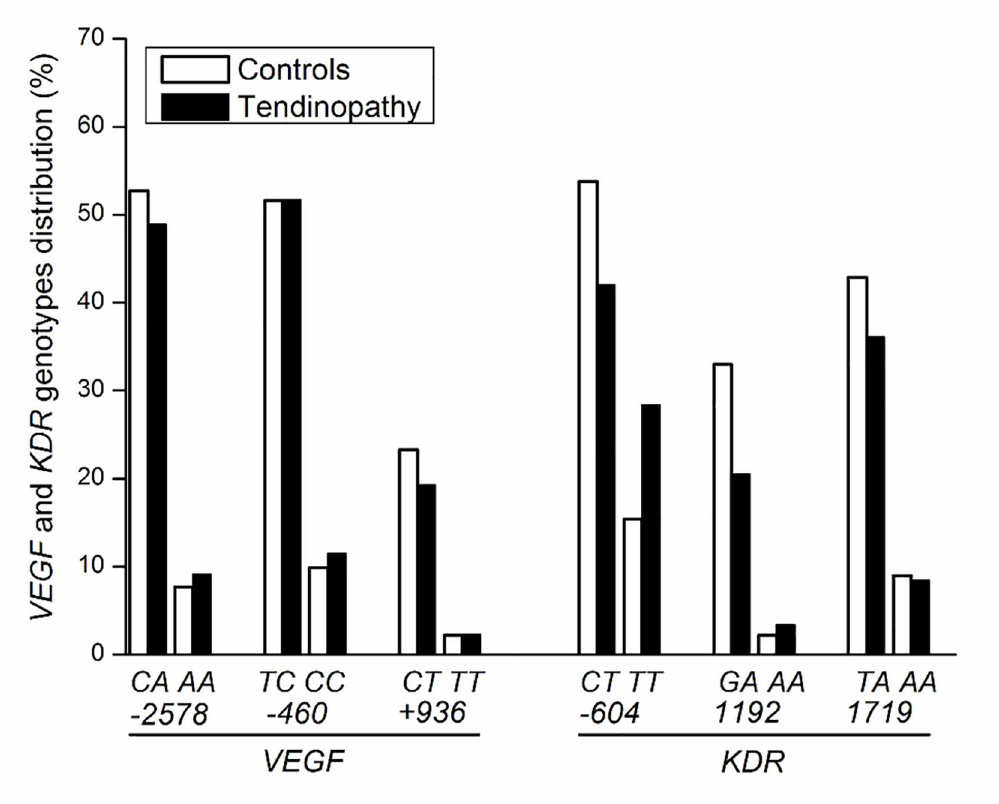
Fig 2. Genotypic distribution of VEGF and KDR polymorphisms in volleyball athletes.